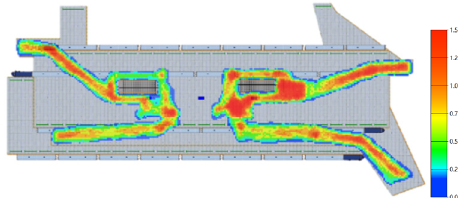
Figure 17. Evacuation of 30% elderly and children.